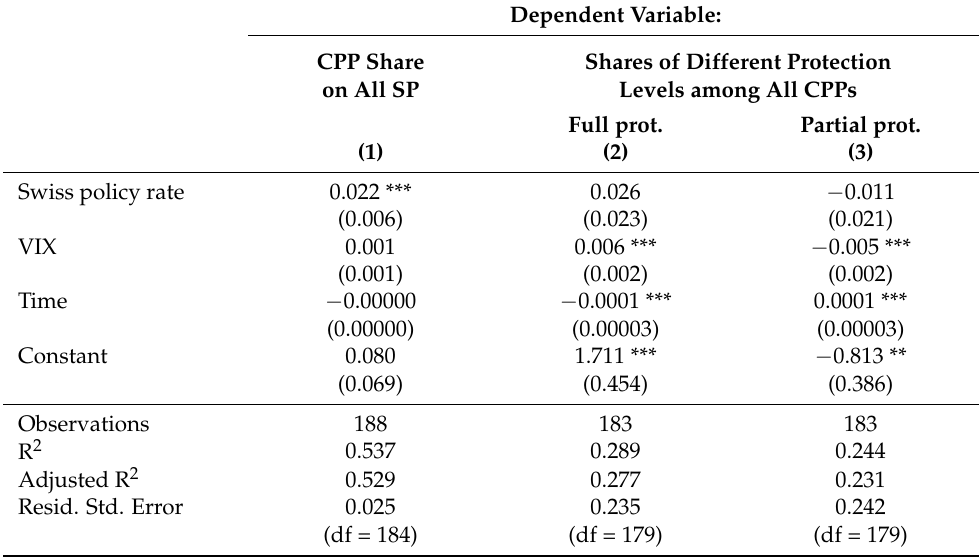
Table 2. Influence of the interest rate on the issuance of capital protected products (CPP) and the share of full and partial protection.